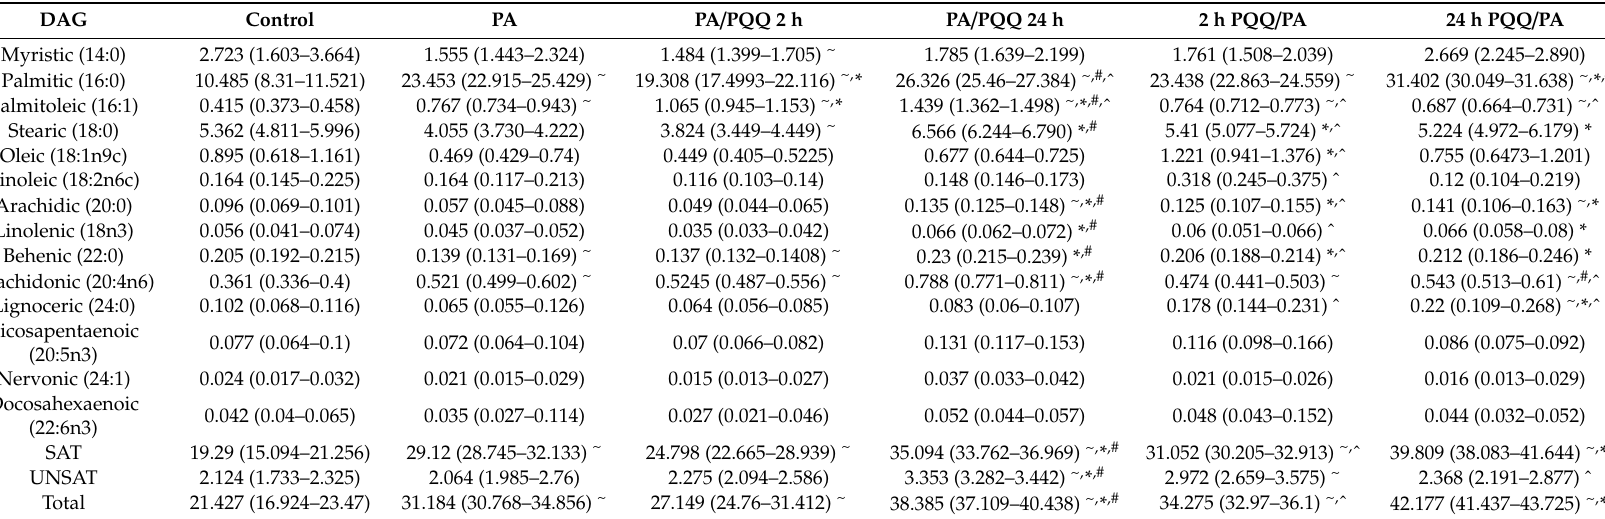
Table A2. Diacylglycerols (DAG) content and composition in L6 muscle cells. The values (nmol mg − 1 of protein) are expressed as: median (25%–75%) based on six independent determinations. The Kruskal–Wallis test followed by a post hoc adjustment was applied. ~ p < 0.05, PA versus control; * p < 0.05, study group (co-cultured with PQQ) versus PA; # p < 0.05, time-dependent di ff erences (long- versus short-time incubation with PQQ); ˆ p < 0.05, sequence-dependent di ff erences (pre-incubation with PQQ versus post-incubation with PQQ). PA: palmitic acid; PQQ: pyrroloquinoline quinone; SAT: saturated fatty acids; UNSAT: unsaturated fatty